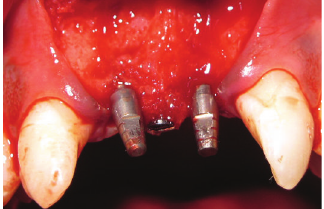
Figure 5: Implant with final prosthesis at 6